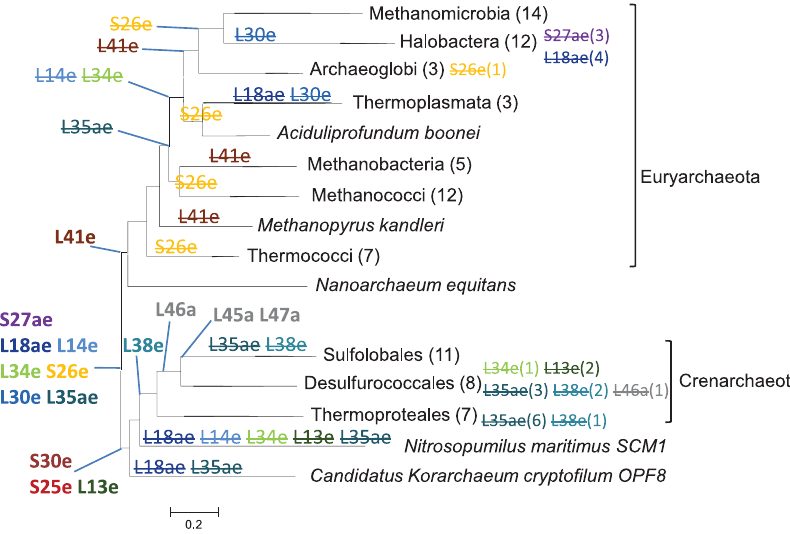
Figure 6. Phyletic distribution of twelve non-ubiquitous archaeal r-proteins. Numbers in parentheses and strikethrough font mean the same as on Figure 3.